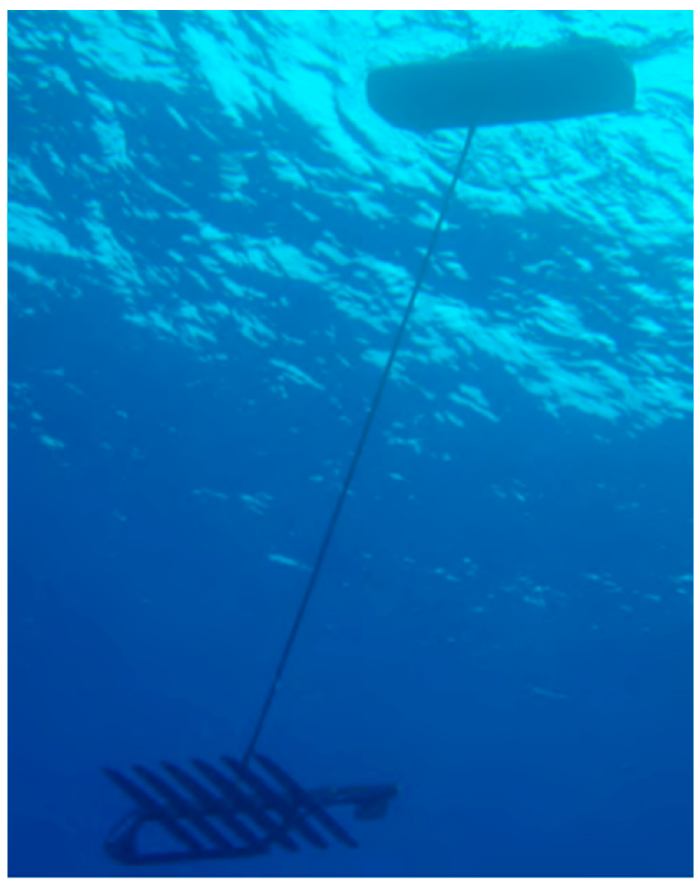
Figure 1. Wave Glider.